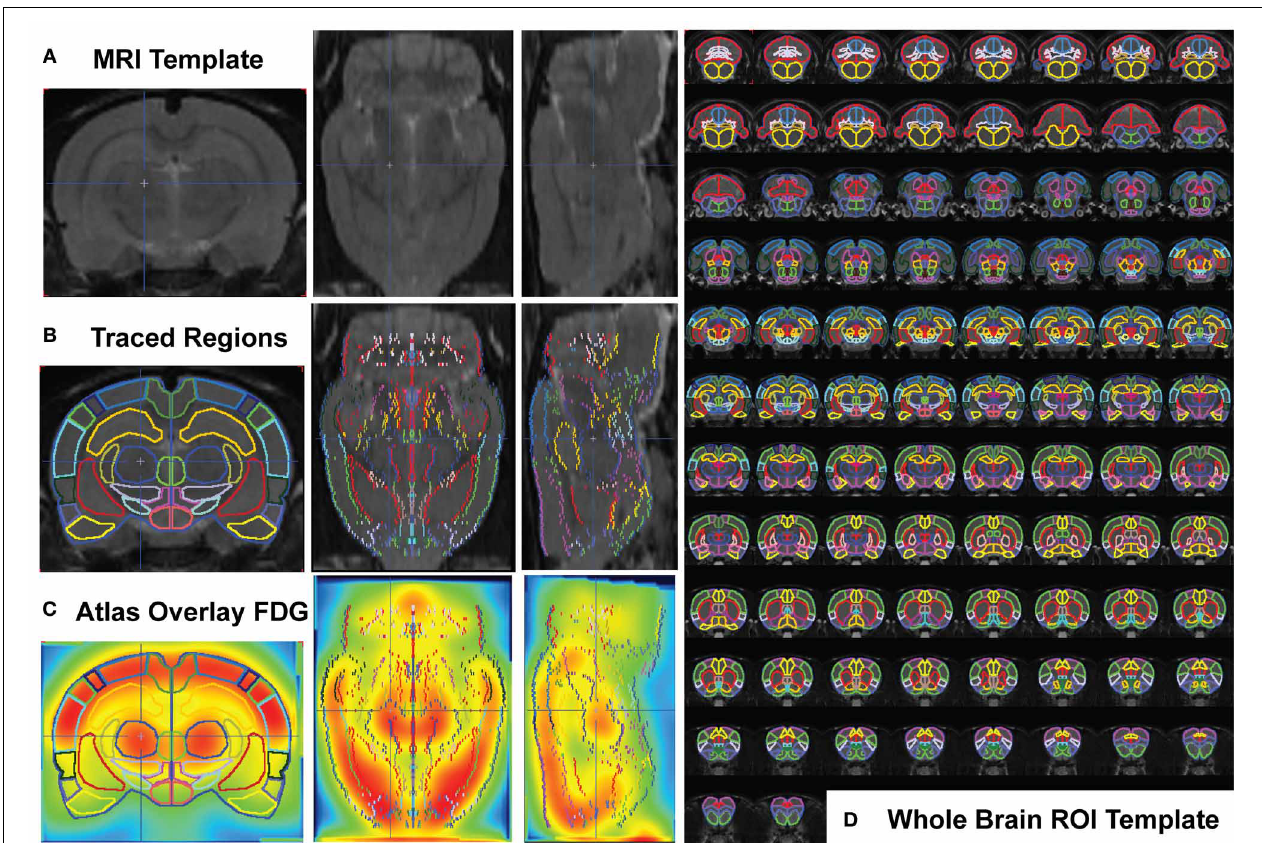
FIGURE 1 | Whole Brain PET Analysis. (A) T2-weighted rat template (Schweinhardt et al., 2003) in coronal (left), transverse (middle), and sagittal (right) views. (B) Each slice of the template (left half of symmetrical coronal section) was hand traced using the PMOD Biomedical Image Quantification Software (www.pmod.com), region-of-interest (ROI) analysis tool, and each